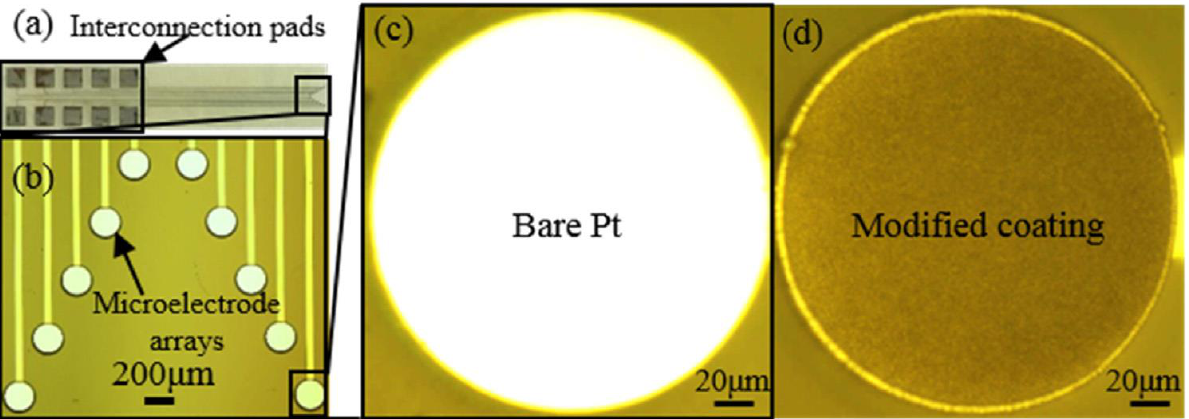
Figure 2. ( a ) Layout (2 × 5 arrays) of the fabricated ECoG electrode; ( b ) enlarged optical microscopic view of the recording sites (diameter was 200 µm). ( c ) Bare Pt surface before the surface modification and ( d ) modified surface with Pt-gray coating.